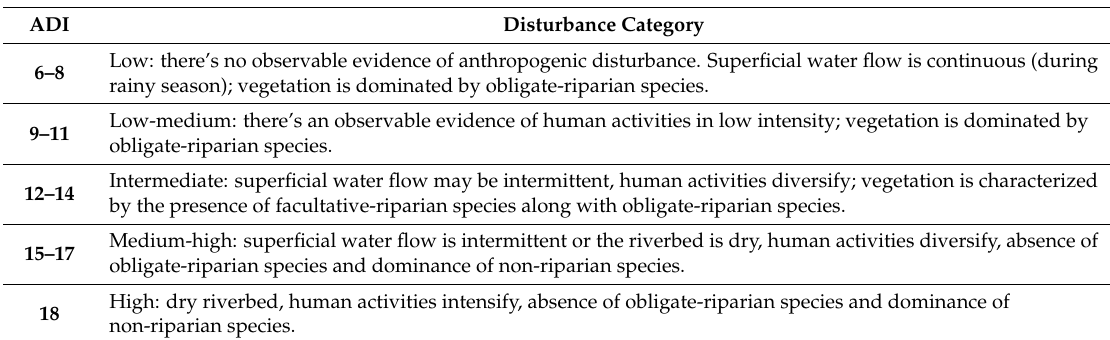
Table 2. Interpretation of the ADI values.